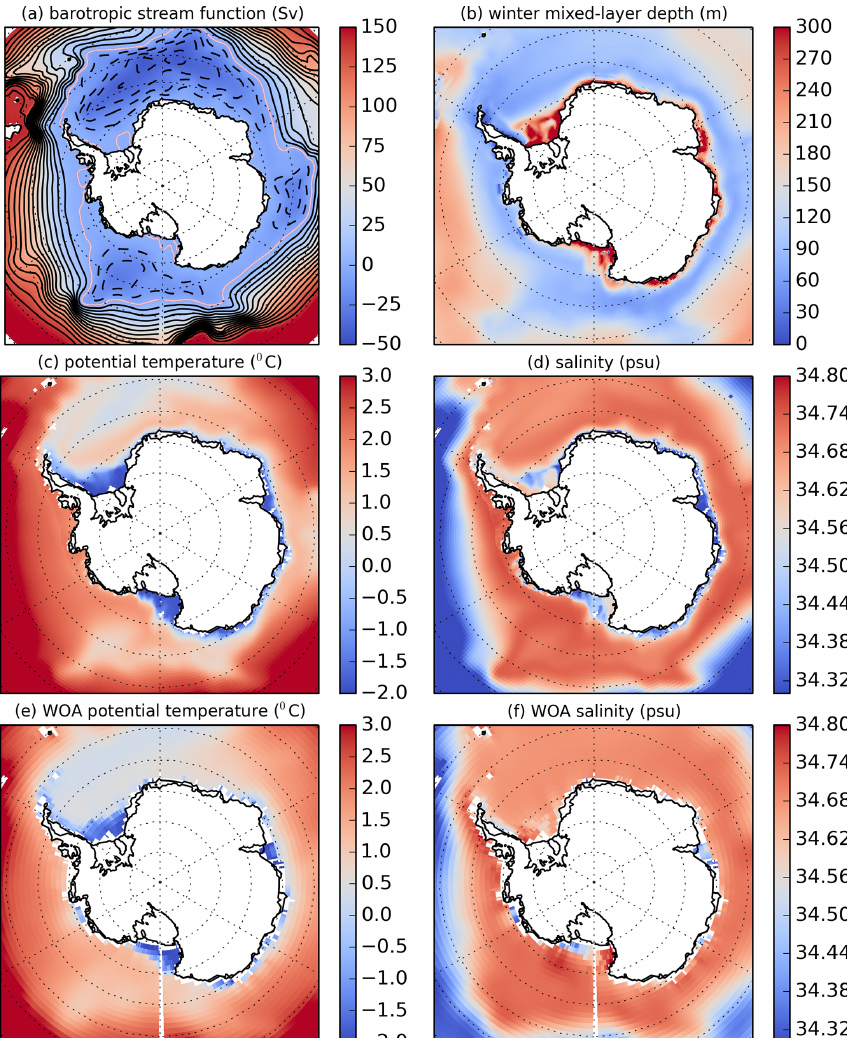
Figure 3. Mean 2020–2030 ALL-EM of (a) barotropic stream function (contours every 10Sv; pink contour is 0Sv), (b) winter (June–July– August) mixed-layer depth (not available in ice shelf cavities), and (c) potential temperature and (d) salinity averaged between 300–1000m. World Ocean Atlas (WOA) 2013 climatology of averaged 300–1000m of (e) potential temperature (Locarnini et al., 2013) and (f) salinity (Zweng et al., 2013). Ice shelf cavities are masked in all plots. In (c) and (d) , a few areas outside the ice sheet with bathymetry < 300m are masked, whereas in (e) and (f) there are bigger masked areas outside the ice sheet extent due to the absence of